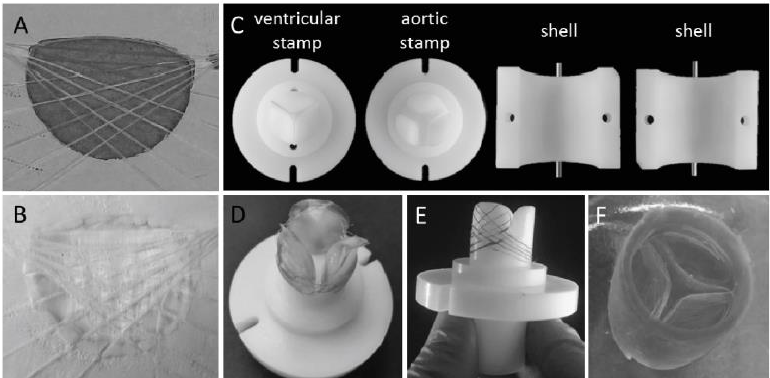
Figure 20. Fabrication process of the BioTexValve. ( A ) Multifilament PLDL fibers fixed on the frame; ( B ) textile composite leaflet after electrospinning; ( C ) molding system; ( D ) leaflets placement on the mold; ( E ) positioning of the PLDL fibers to create continuity between leaflet and wall; ( F ) complete valve fabrication after fibrin gel injection and demolding. Reprinted with permission from ref. [134]. Copyright 2016, Wiley.